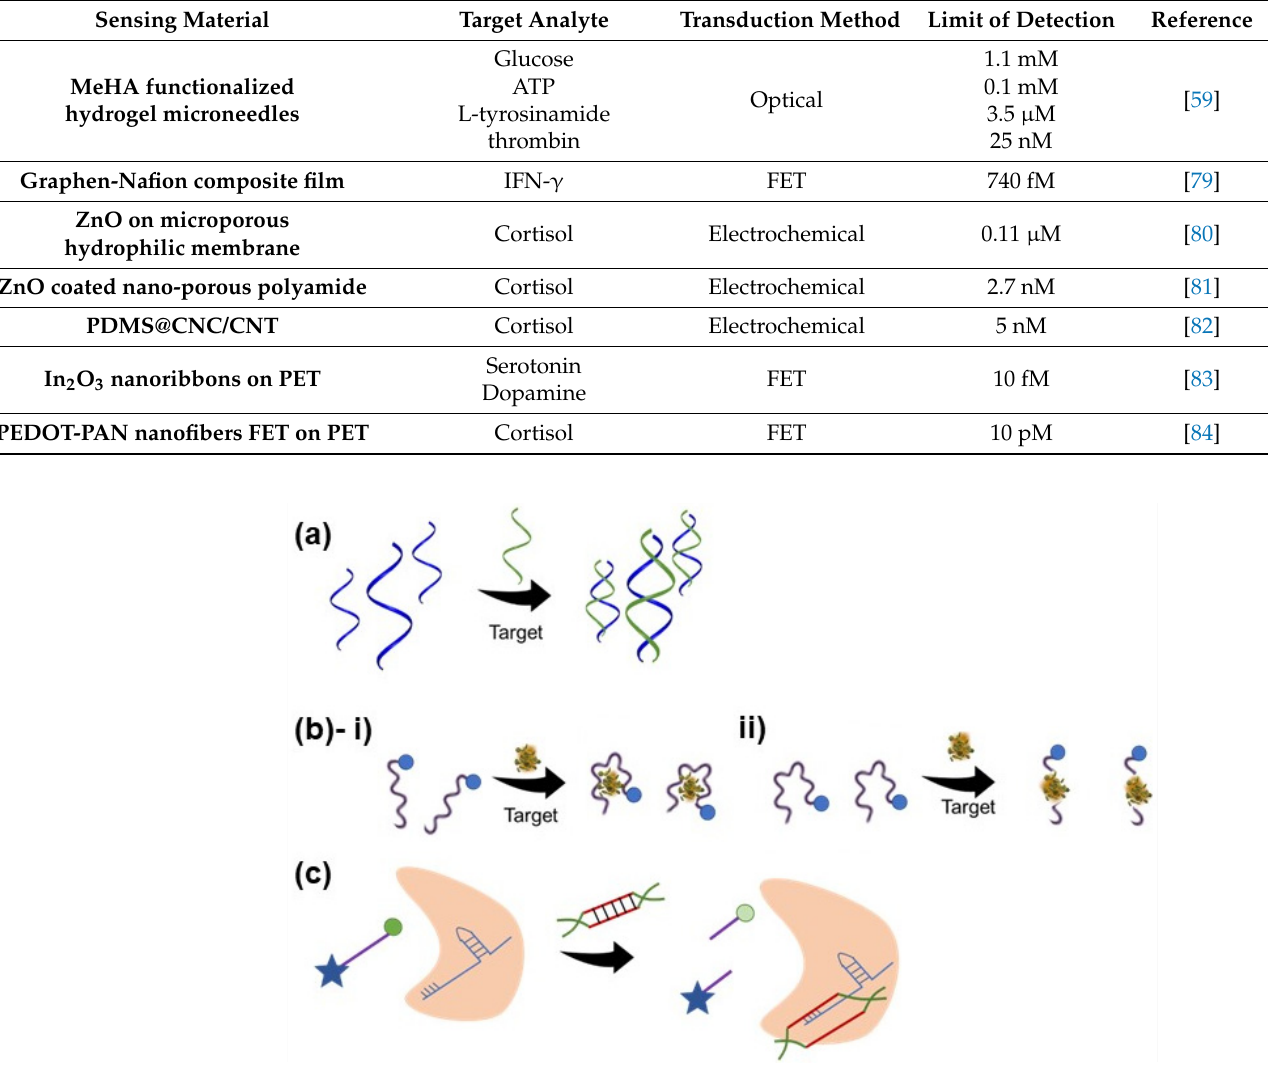
Figure 3. Design of assays for ( a ) synthetic oligonucleotides; target ssDNA hybridizes with the complementary sequence of the ssDNA probe and forms a nucleic acid duplex, ( b ) aptamers; upon binding to their target via intermolecular interactions, aptamers undergo a three-dimensional ( i ) signal on and ( ii ) signal off conformation rearrangement, and ( c ) CRISPR-Cas; Cas enzymes, upon binding to RNAs, form a complex which can search for and cleave target sequences complementary to the